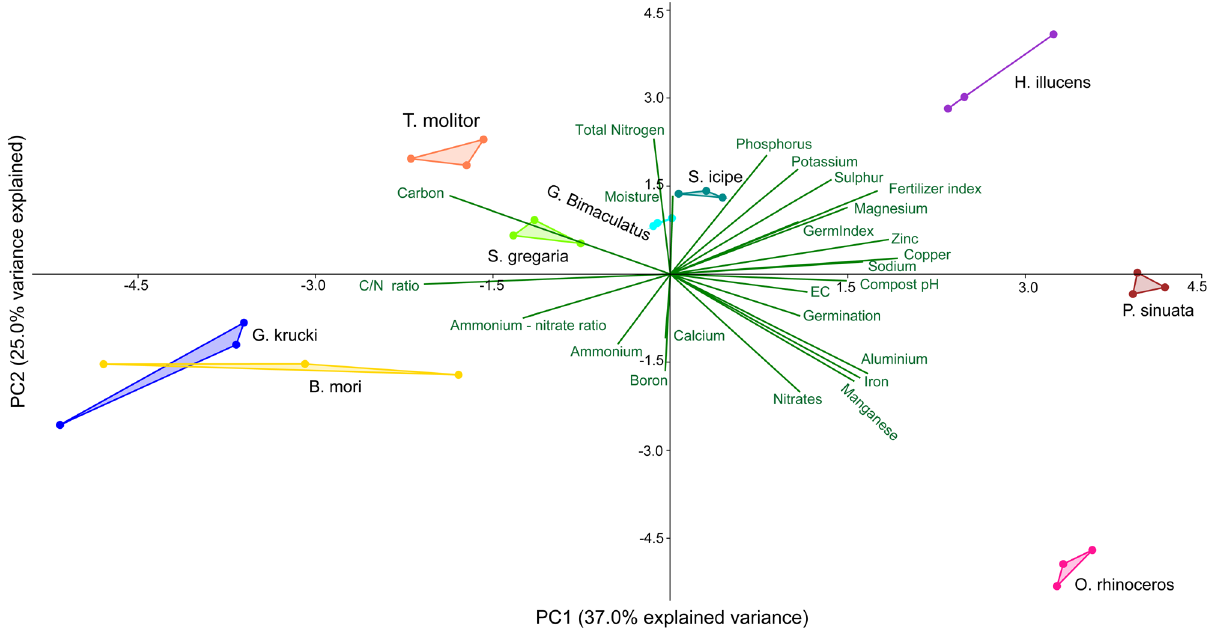
Figure 3. Biplot graphs based on the principal component (PC) analysis of parameters that measure the quality of frass fertilizer composts produced by different edible insect species (n =